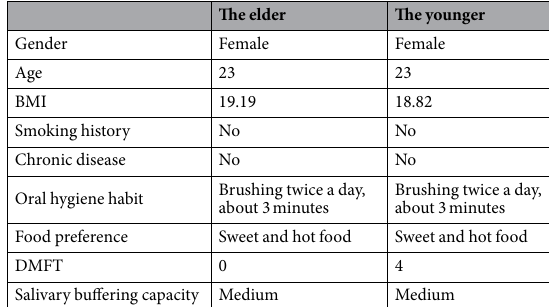
Table 1. General characteristics of the twins recruited in this